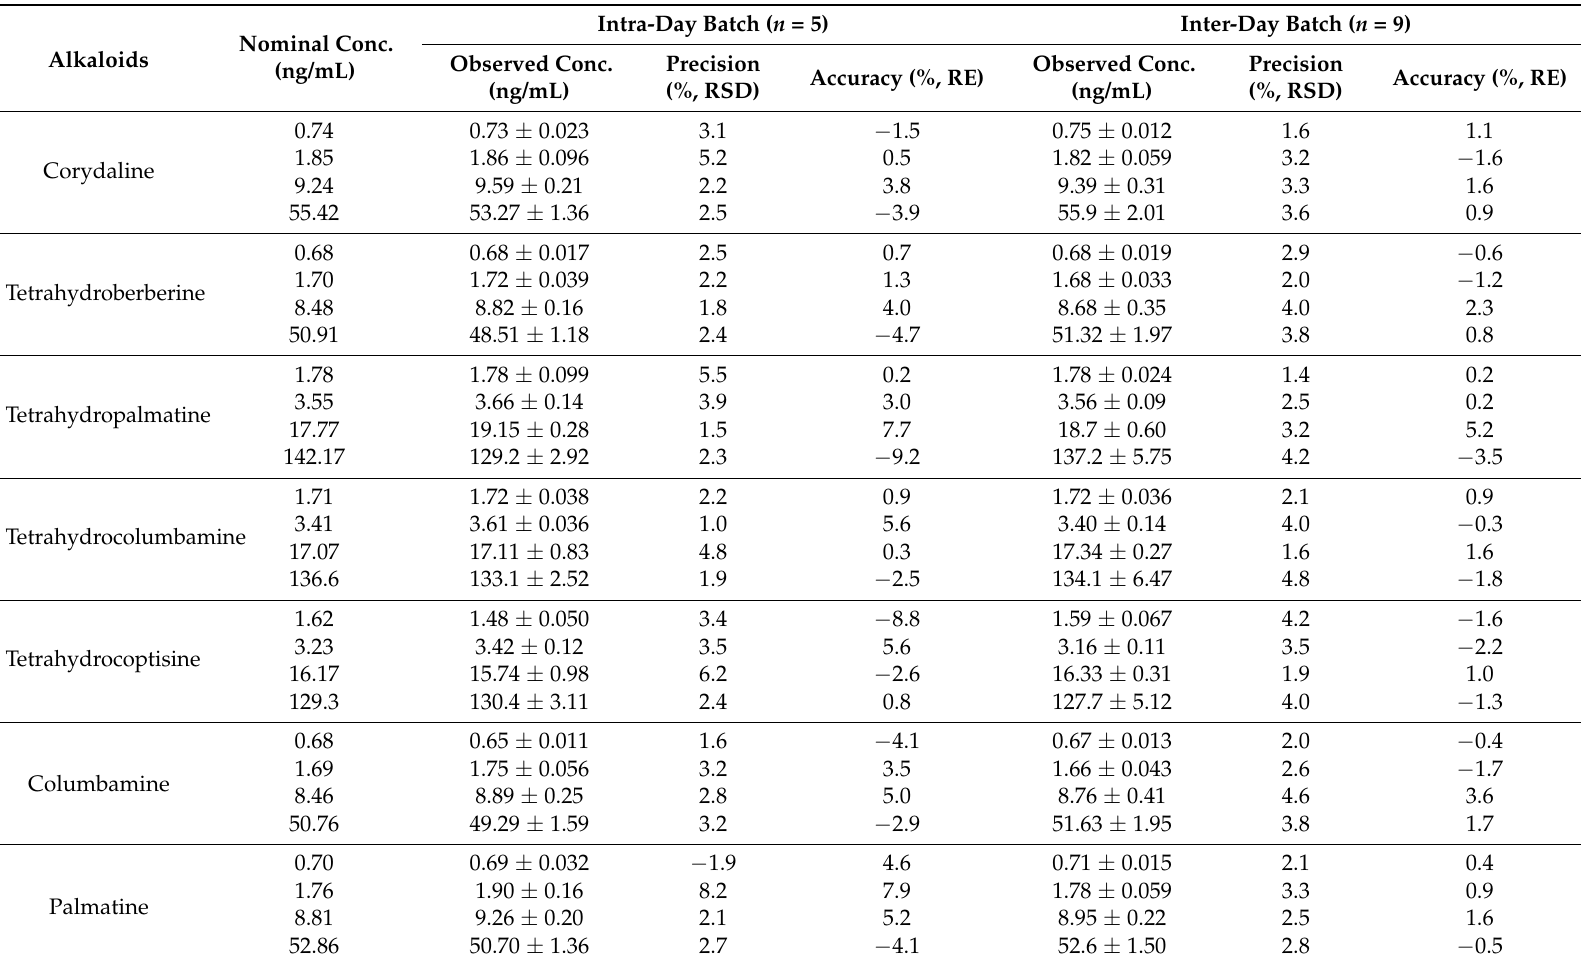
Table 3. Intra-day and inter-day precisions and accuracies of the fourteen alkaloids from the assay samples (mean ± SD).